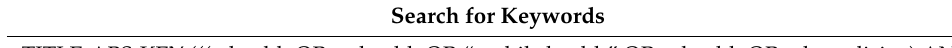
Table 1. Bibliographic search strategy.